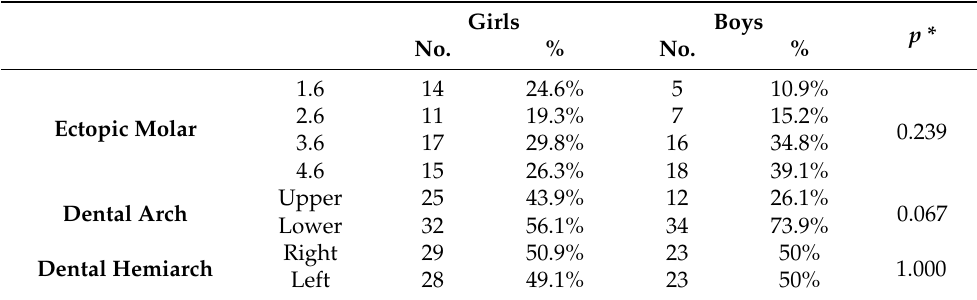
Table 2. Distribution of the ectopic molars according to gender and type of molars/affected dental arch/affected dental hemiarch.